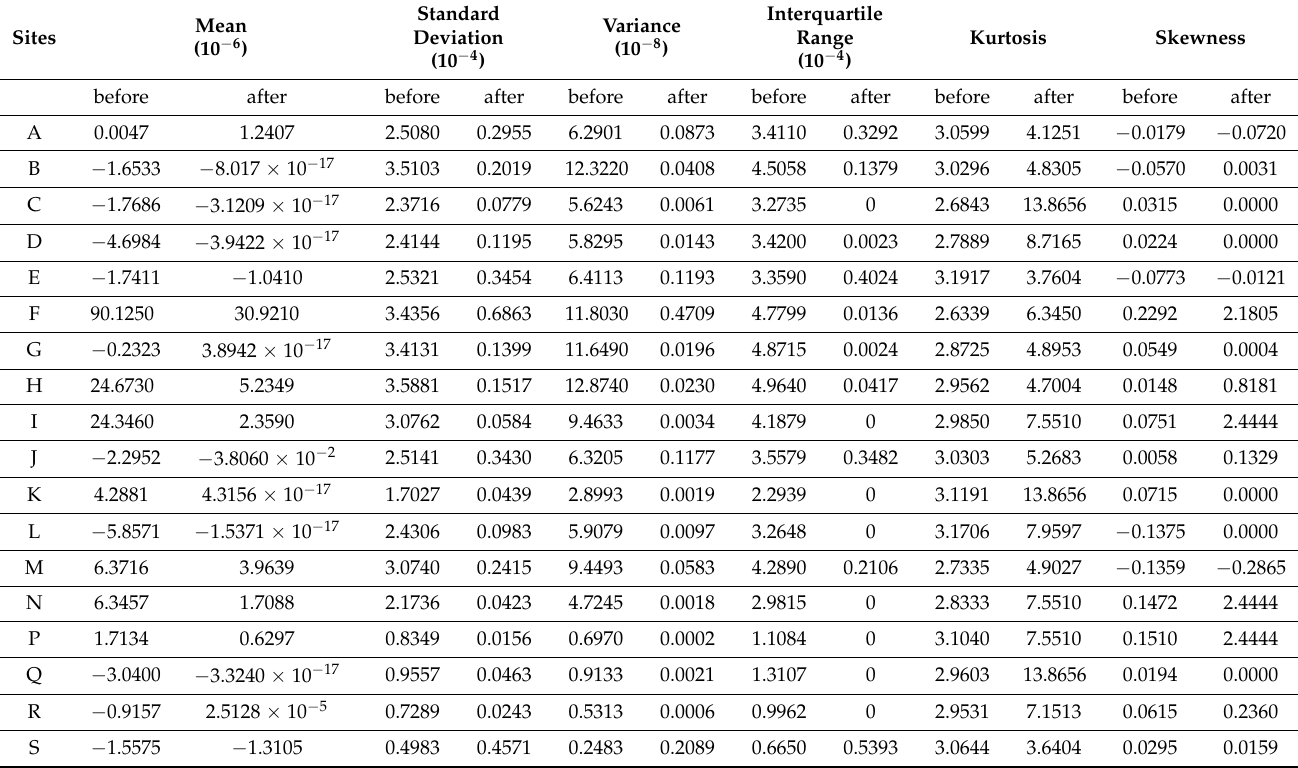
Figure 54. Histogram and PDF of Denoised Site J at 6 GHz band horizontal polarization. Furthermore, Figure 52 presents the histogram and PDF of the denoised site I signal at the 6 GHz band horizontal polarization. The histogram and PDF of the site J signals at the 6 GHz band horizontal polarization are given in Figure 53. Additionally, the histogram and PDF of the denoised site J signals at the 6 GHz band horizontal polarization are presented in Figure 54. Finally, the statistical analysis showing the performances of the links before and after denoising at 6 GHz in horizontal polarization is summarized in Table 12. Table 12. Statistical analysis showing the performances of the links before and after denoising at 6 GHz horizontal